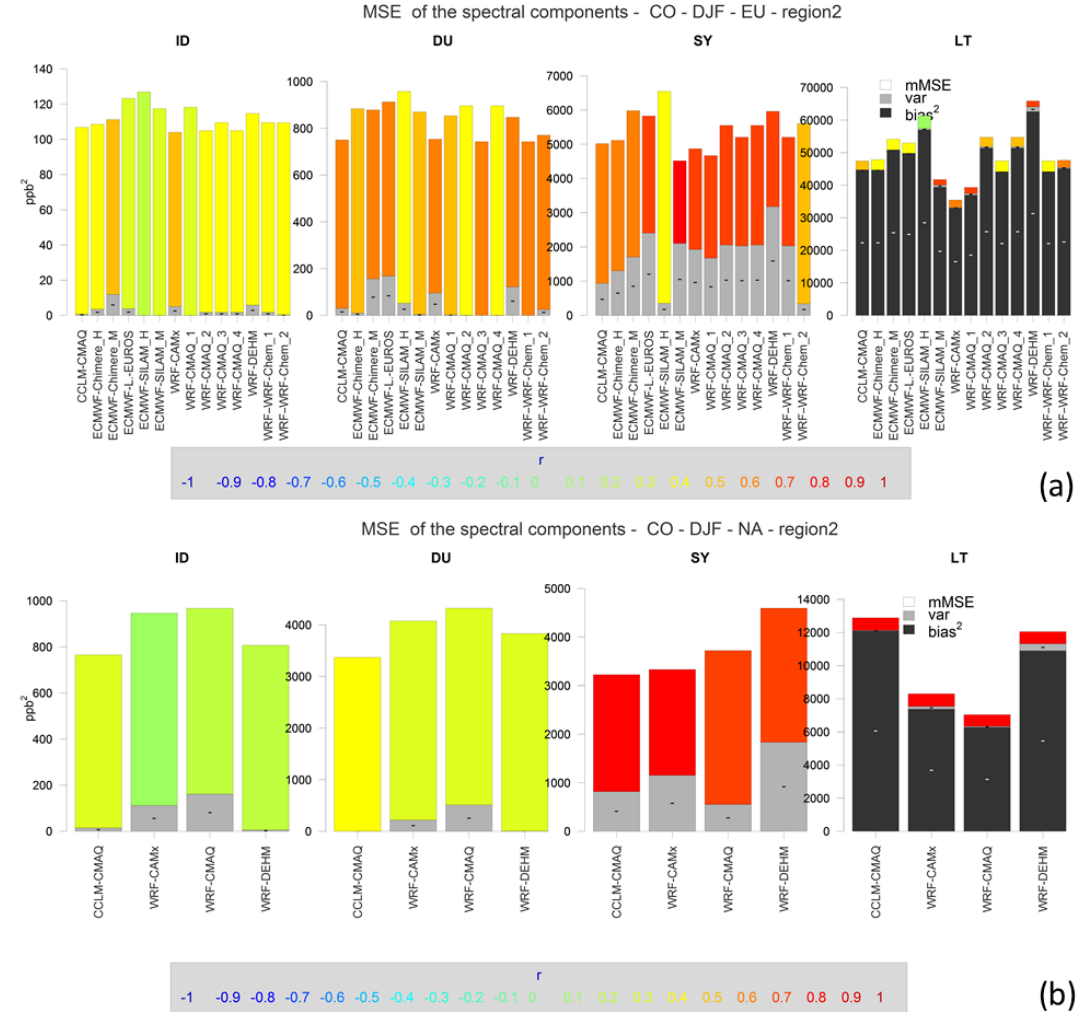
Figure 10. MSE (ppb 2 ) breakdown into bias squared, variance, and mMSE for the spectral components of the spatial average time series of CO during the months of December, January, and February (DJF) based on Eq. (6). The bias is entirely accounted for by the LT component. The signs within the bias and variance portion of the bars indicate model overestimation ( + ) or underestimation ( − ) of the bias and variance. The color of the mMSE share of the error is coded based on the values of r , the correlation coefficient, according to the color scale at the bottom of each plot. Top panel is EU; lower panel is NA. Similar plots for the other two subregions are reported in the